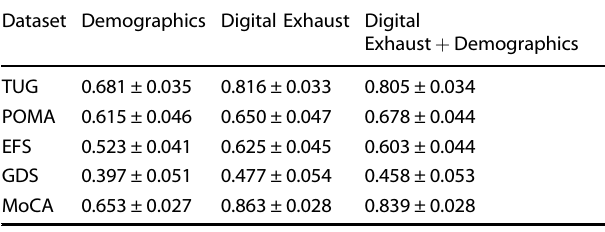
Table 2. Performance Evaluation based on PrAUC. Dataset Demographics Digital Exhaust Digital